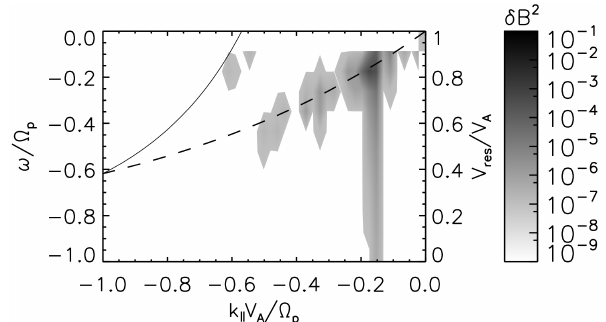
Figure 4. By solid and dashed lines are given the normalized reso- nance velocity (solid line) of ions in dependence with the wavenum- ber according to Eq. (2) (see right axis). By dashed line is presented the dispersion relation for cold plasma (see left axis). Overplotted in a gray-coded scale, the frequency–wavenumber spectrum of the magnetic field fluctuations is given at time t(cid:127) p =